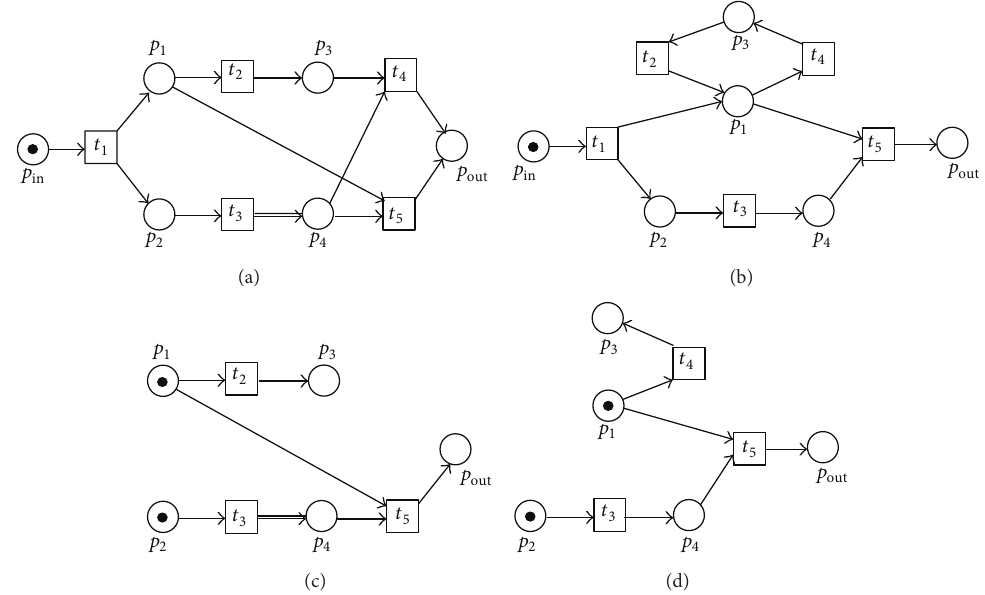
) , (b) a sound and well-structured WF-system ( 𝑁 󸀠 , 𝑀 󸀠 in